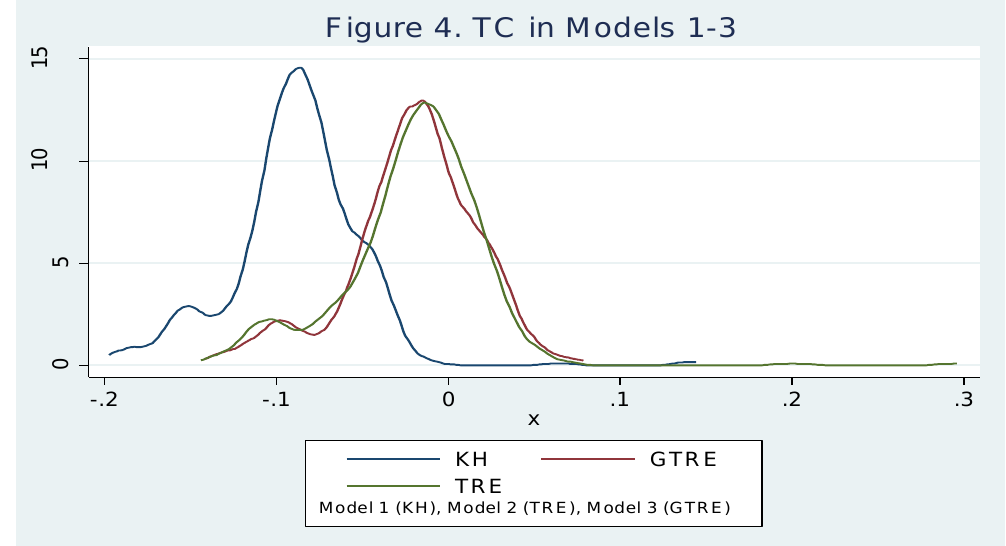
Figure 4. TC in Models 1-3.